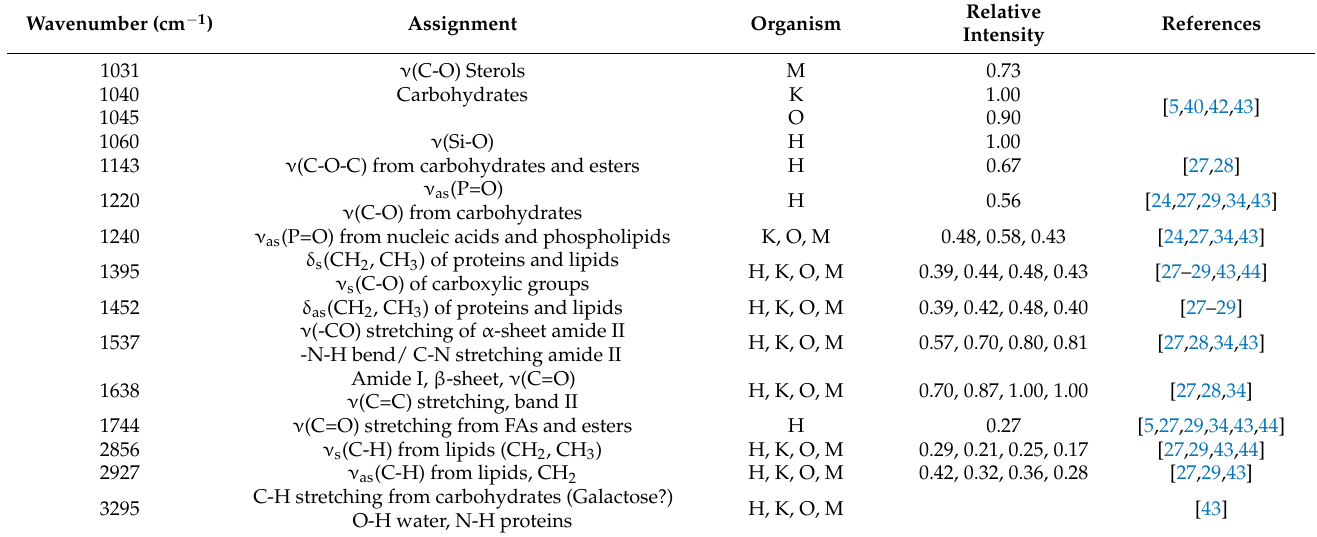
Table 5. Band assignments for FTIR spectra of three algae and one cyanobacterium. M, Microcoleus vaginatus ; H, Haslea spicula ; K, Klebsormidium flaccidum ; O, Oocystis sp. Wavenumber (cm − 1